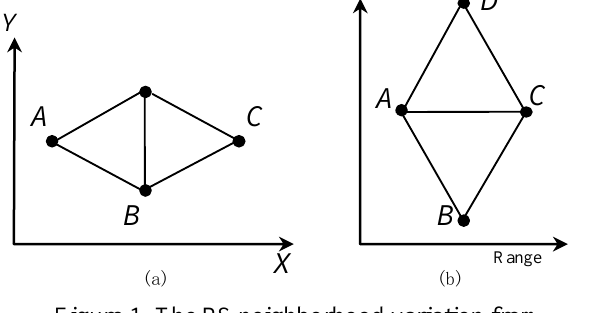
Figure 1. The PS neighborhood variation from geography space to image